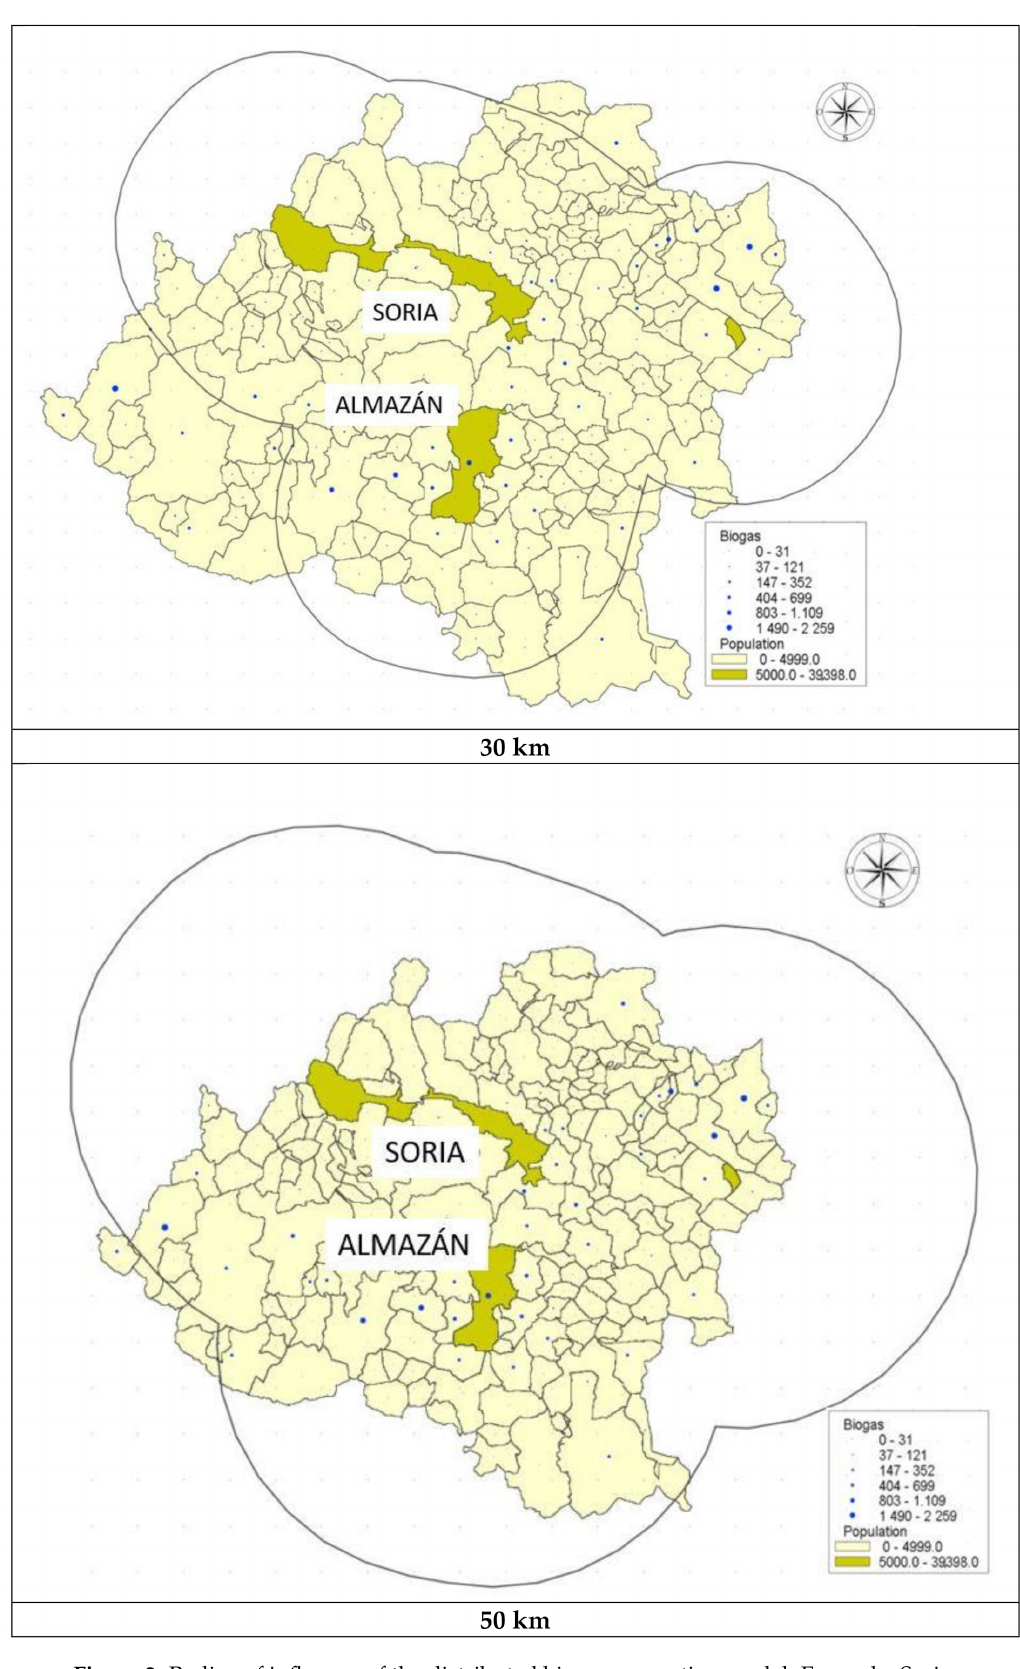
Figure 2. Radius of influence of the distributed biogas generation model. Example: